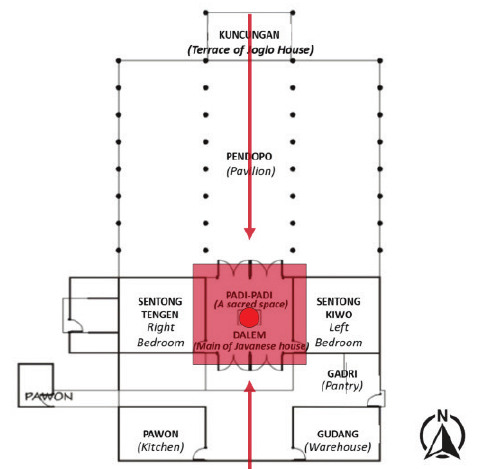
Figure 6. The space of padi-padi representing the sacred space due to the respect to the ancestors and the rulers in the past (source: Survey, 2017)